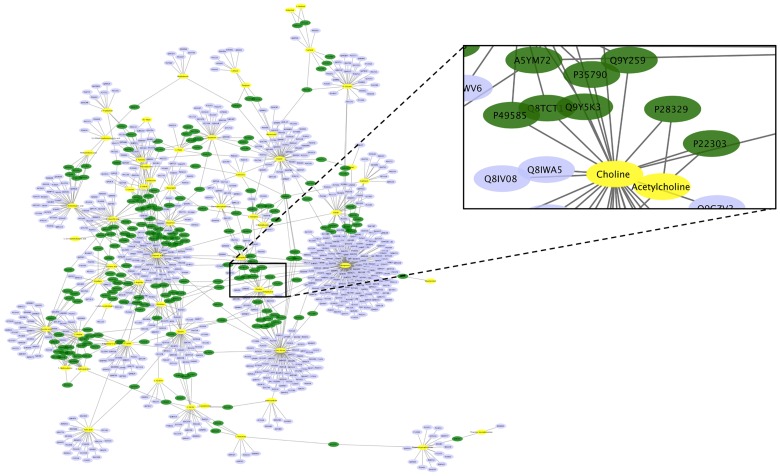
AD related protein-metabolite network.1179 protein-metabolite interactions were indicated from the HMDB database. The zoomed-in inset shows that acetylcholinesterase (P22303), a known anti-AD target, interacts with 2 AD-related metabolites (Choline and Acetylcholine). The nodes with yellow color represent metabolites that were altered in AD patients, the nodes with purple color represent proteins that linked to AD associated metabolites, and the nodes with green color represent proteins that linked to ≥2 AD associated metabolites.